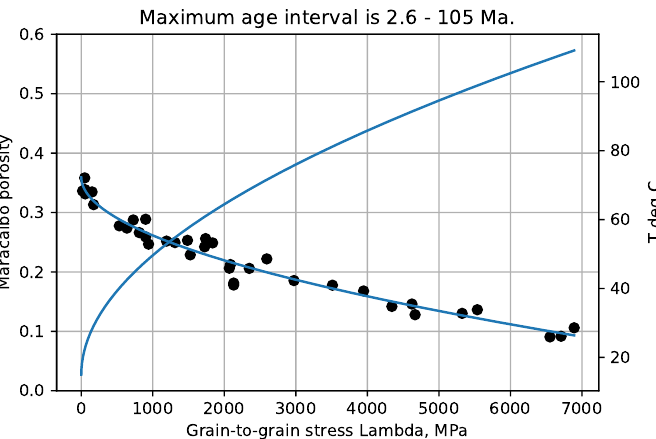
Figure 12. Maracaibo porosity trend.